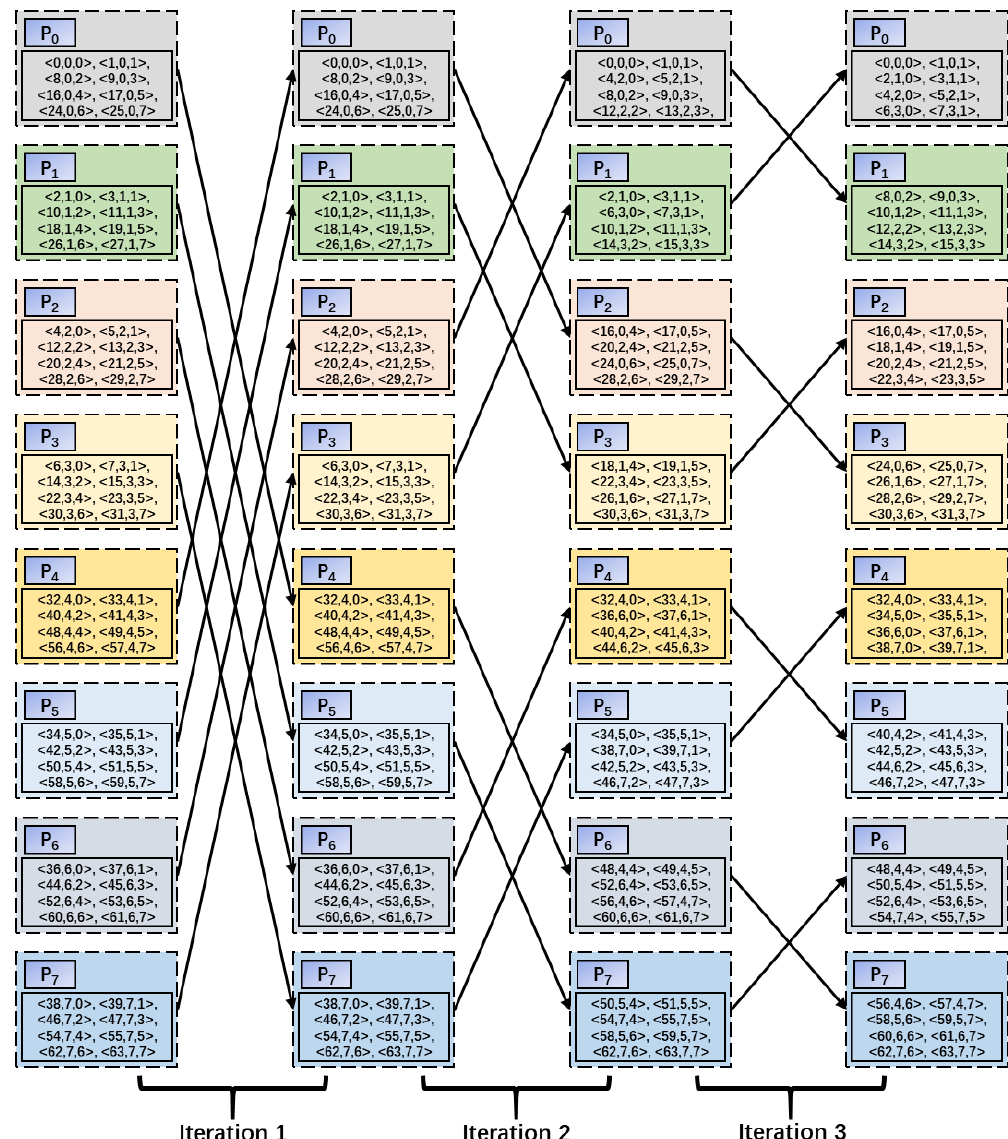
Figure 3. The distributed sort corresponding to the CLGMT entries in Table 1. Each iteration makes the CLGMT entries with larger global cell indices reserved in the processes with larger IDs. For example, after the first iteration, the CLGMT entries with global cell indices between 0 and 31 are reserved in P0–P3, while the remaining CLGMT entries are reserved in P4–P7. Table 3. The distributed CLGMT after rearranging the CLGMT entries in Table